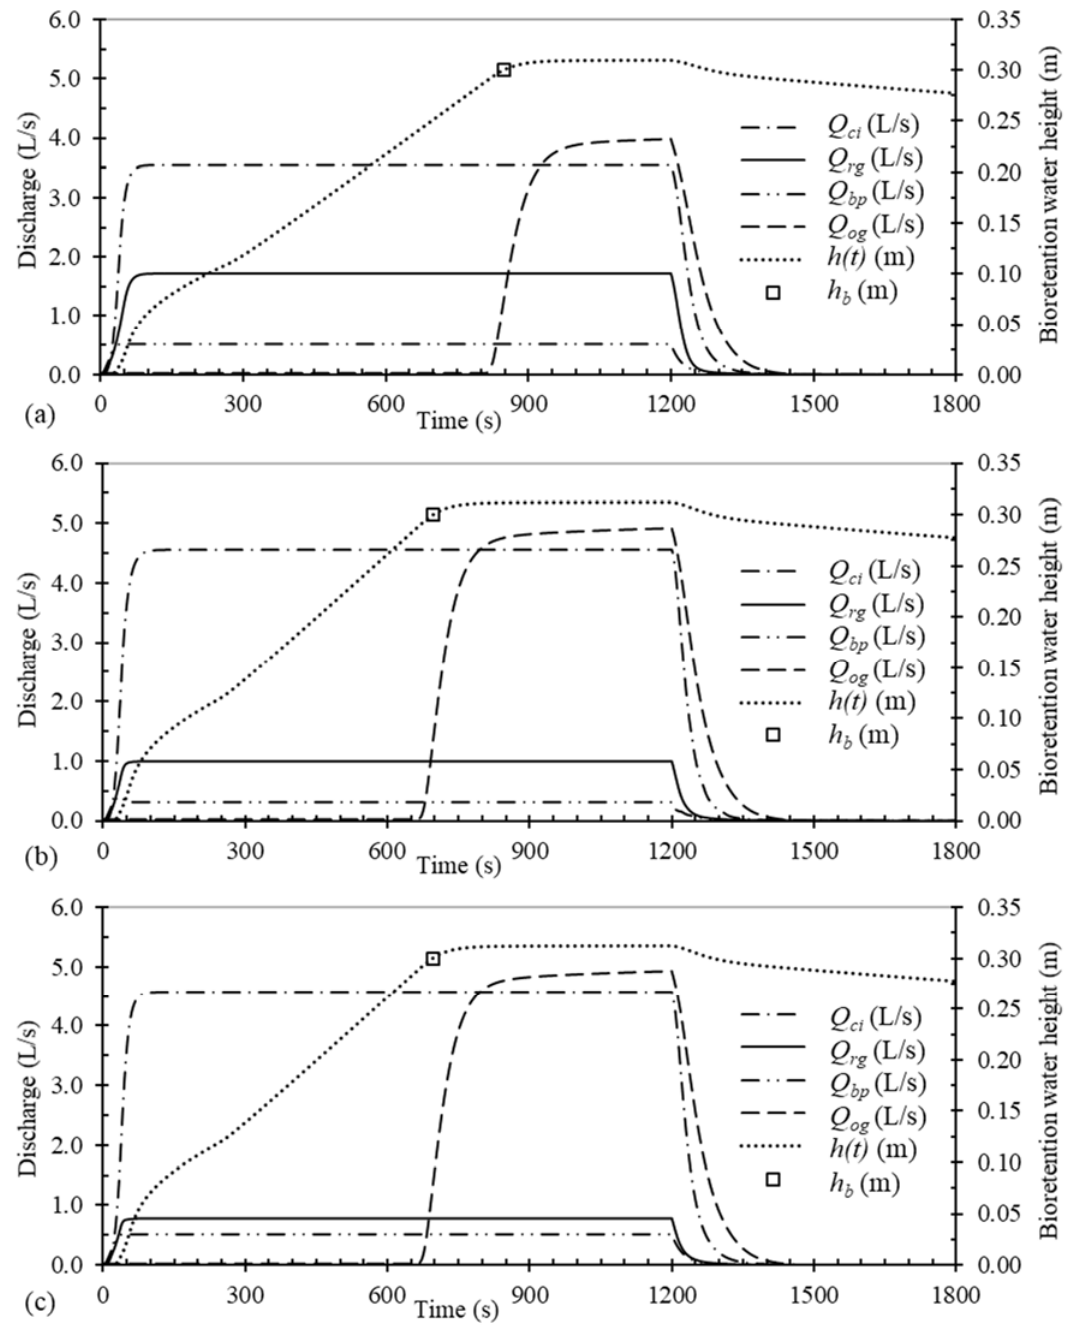
Figure 4. Simulated hydrograph and bioretention water depth of three cases ( a ) Und27, ( b ) Com27, and ( c ) Loc27.